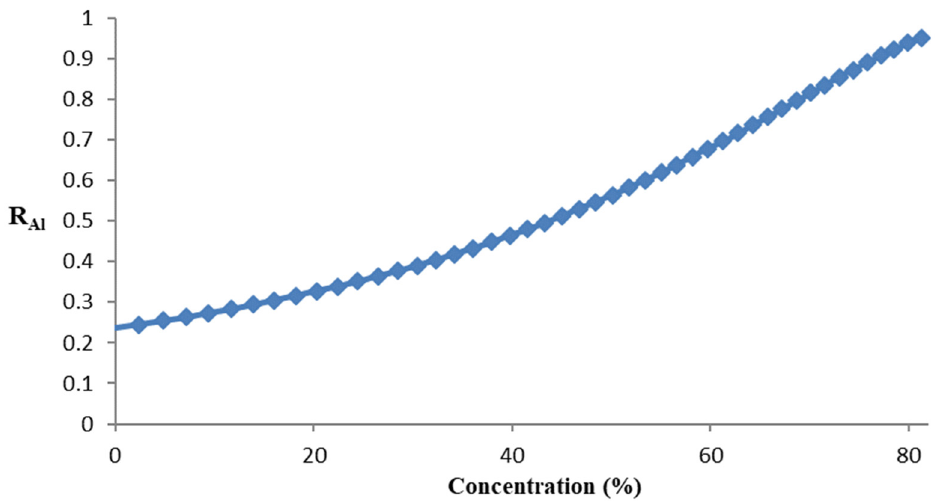
Figure 7. Reflectance curve vs. the concentration of sucrose.